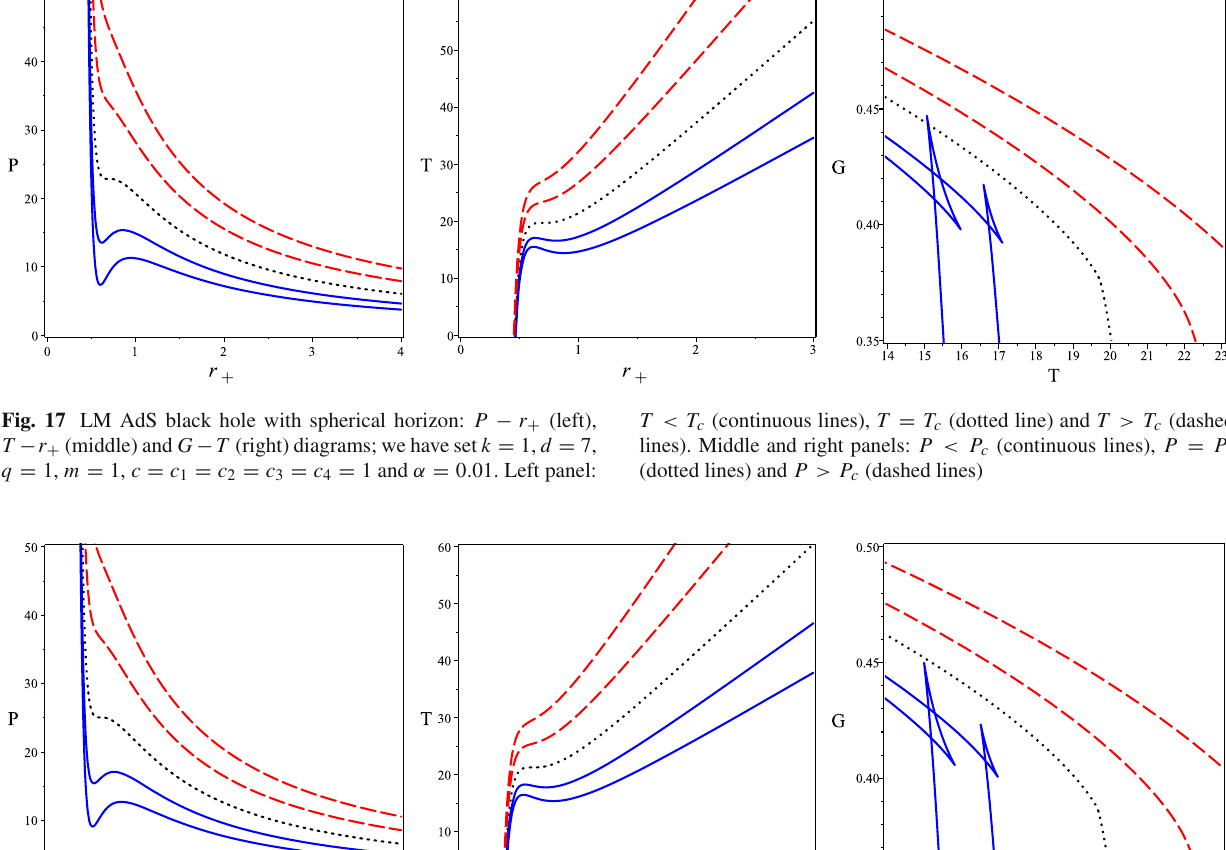
(continuous lines), T = T c (dotted line) and T > T c (dashed lines). Middle and right panels: P < P c (continuous lines), P = P c (dotted lines) and P > P c (dashed lines)